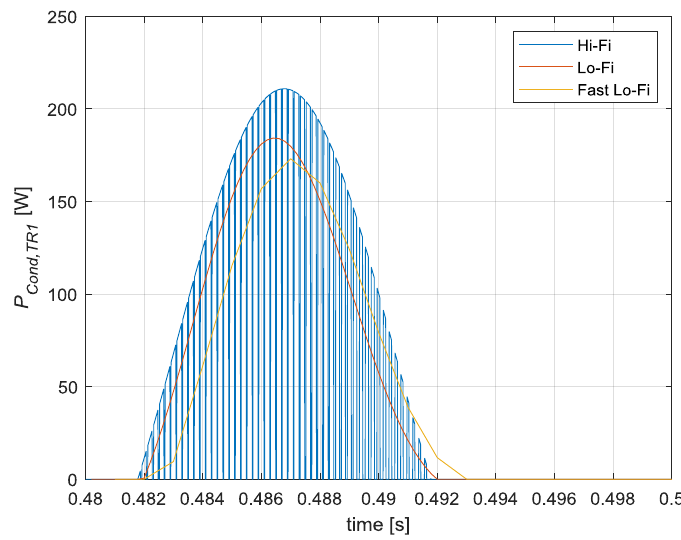
Figure 22. Hi-Fi, Lo-Fi, and Fast Lo-Fi conduction losses comparison. Table 4. Average conduction power losses in Hi-Fi, Lo-Fi, and Fast Lo-Fi models.